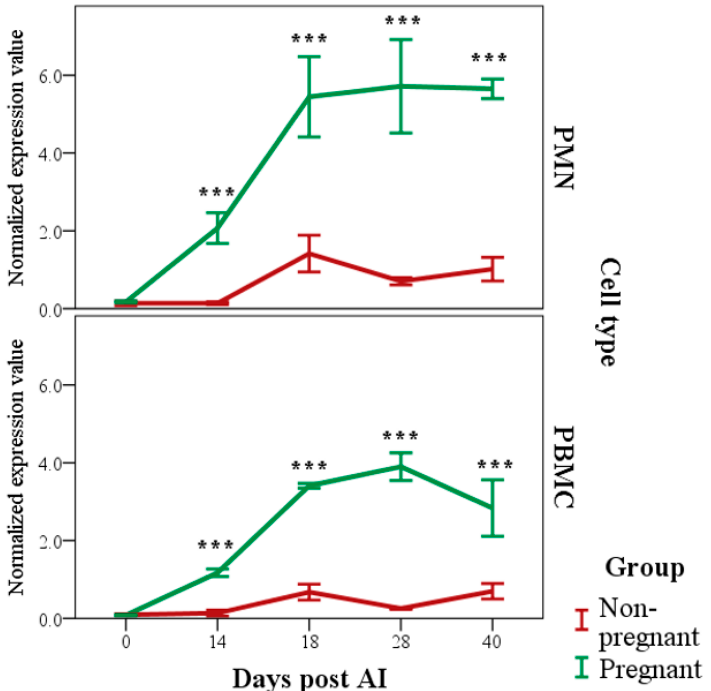
Figure 2. PAG2 expression in granulocytes (PMN, 2 − ∆ Ct ; Upper Panel) and peripheral blood mononuclear cells (PBMC, 2 − ∆ Ct ; Lower Panel) until Day 40 post AI in the Pregnant and Non-pregnant group (mean ± SE, raw data). Differences, in both PMN and PBMC expression, between the Pregnant and Non-pregnant group as well as with respect to Day 0, starting from Day 14 post artificial insemination (AI; *** p < 0.001 Pregnant vs. Non-pregnant and each day of observation vs. Day